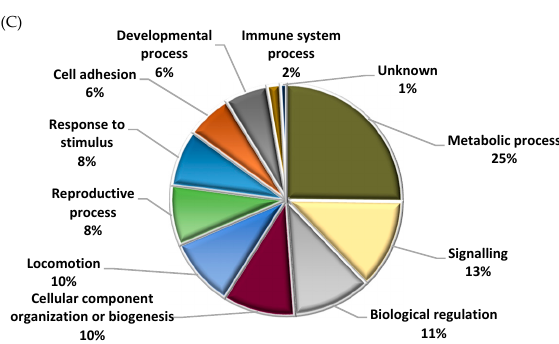
Figure 3. Classification of the identified proteins in fresh and cryopreserved ram sperm incubated in both media (CAP and NC) over time, according to their ( A ) molecular function, ( B ) subcellular location, and ( C ) biological process using Blast2GO and UniProtKB.